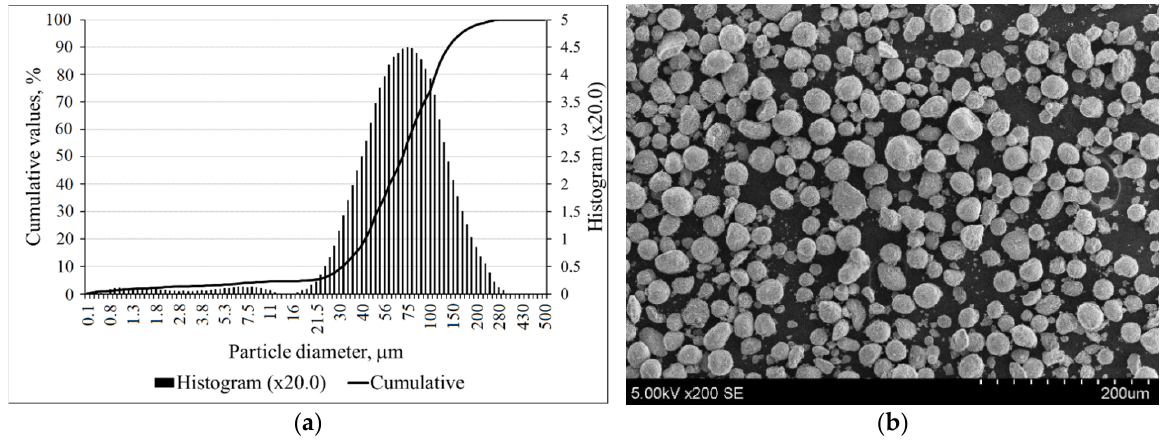
Figure 2. The particle size distributions ( a ); SEM image ( b ) of zeolitic by-product.